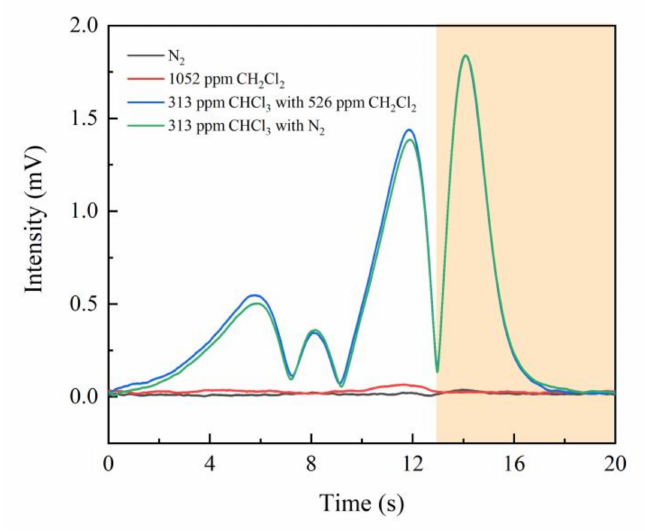
Figure 8. Interference experiment of dichloromethane on chloroform. 1f PA signals of different kinds of gases are plotted with a scanning period of 20 s (colored area is the selected effective